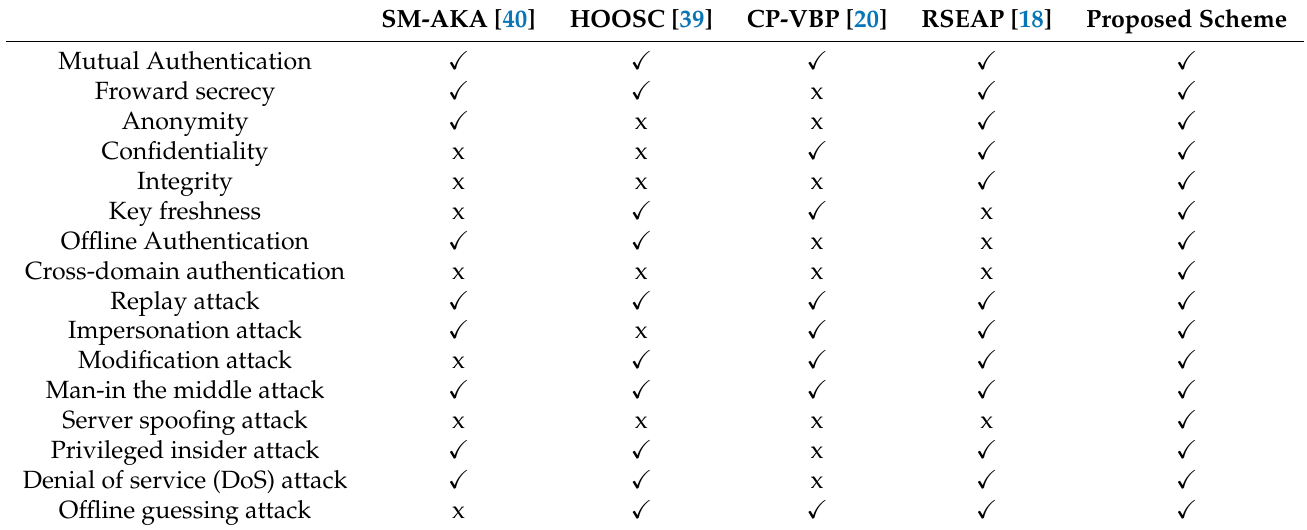
Table 3. A comparison of security features.